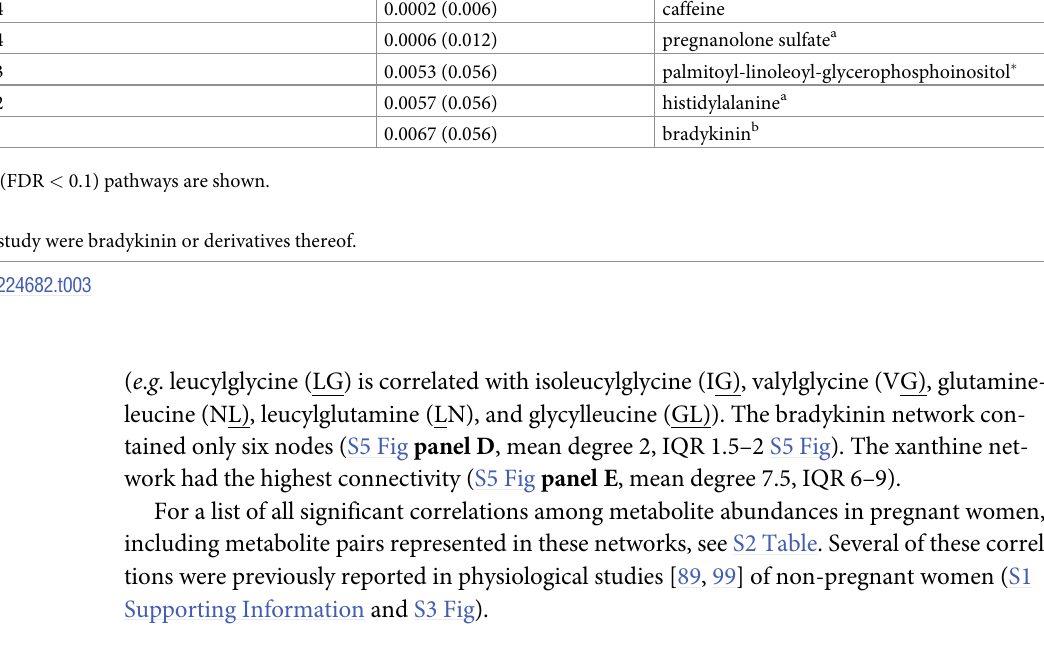
Table 3. Pathways perturbed in pregnancy.